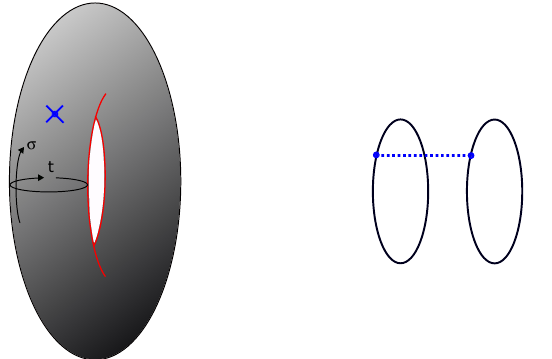
Figure 11 . Left: Liouville torus one-point function. Right: in the double scaling limit we end up with two Schwarzian-like systems, one from the holomorphic and one from the anti-holomorphic sector. They interact through the integral over λ and operator